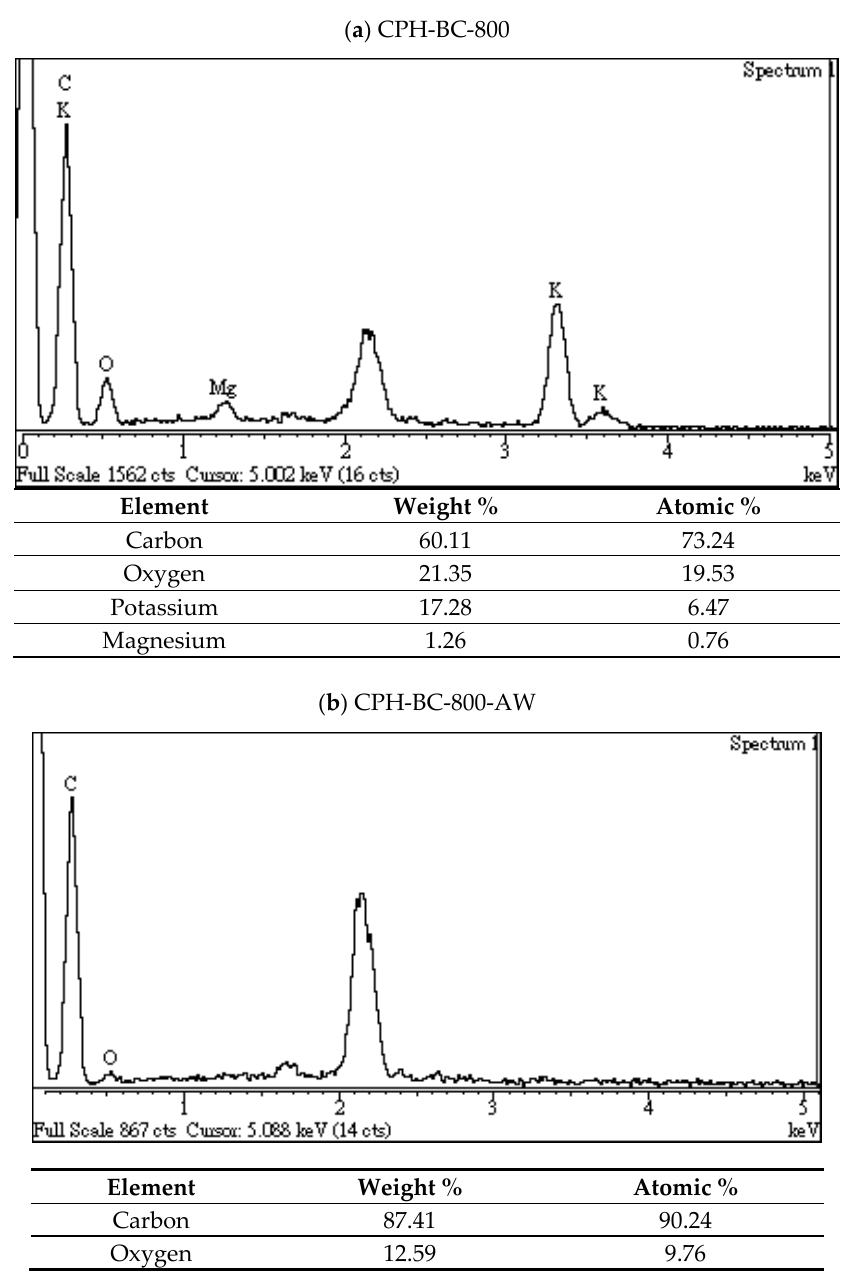
Figure 4. Energy dispersive spectroscopy (EDS) spectra of ( a ) CPH-BC-800, and ( b ) CPH-BC-800-AW.